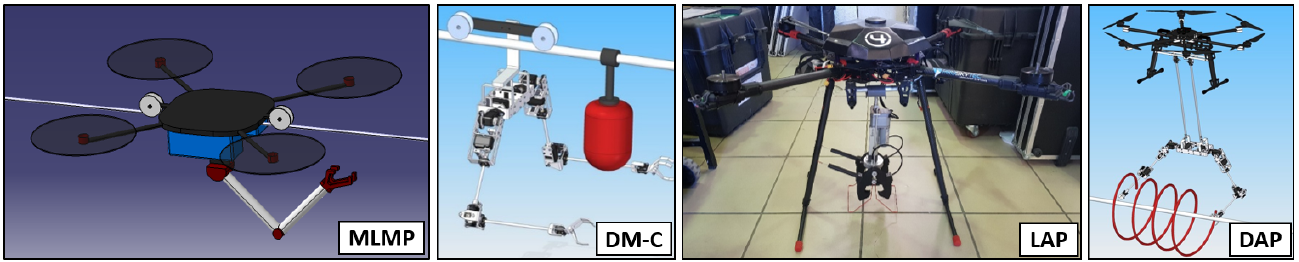
Figure 3. Aerial manipulation platforms: Main Local-Manipulation Platform (MLMP), Deployable Manipulator with Carriage (DM-C), Linear-Actuator Platform (LAP), and Dual-Arm Platform